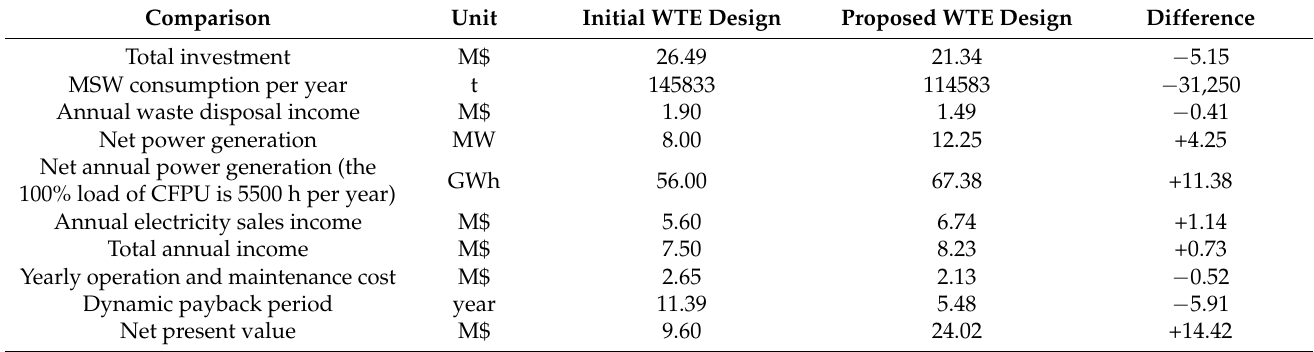
Table 20. Comparison of economic analysis results between the initial and proposed WTE